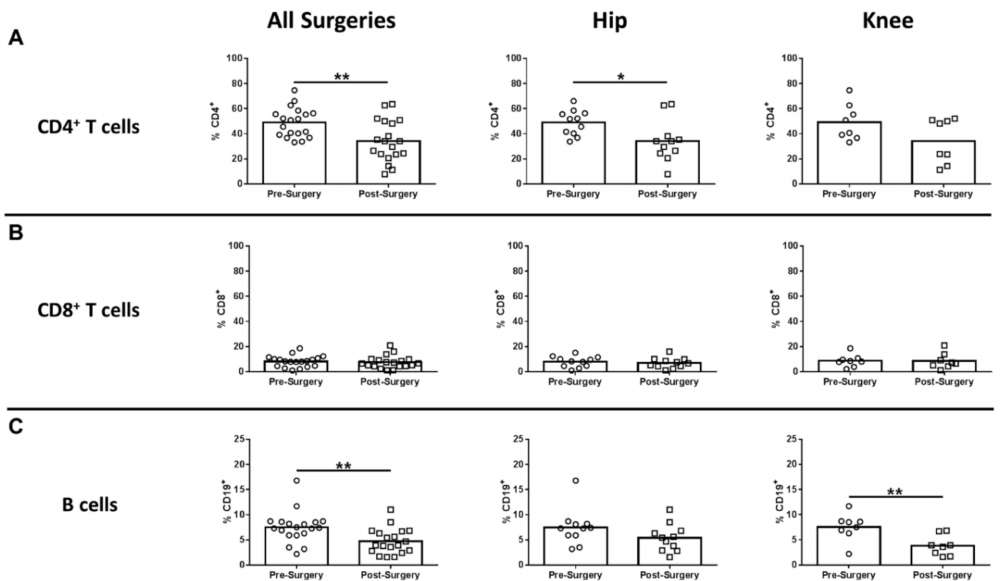
Figure 3. Hip / knee arthroplasty reduces CD4 + T and B cells in the peripheral circulation. Blood samples collected from patients pre- and post-surgery for THA ( n = 11) and TKA ( n = 8) were analyzed by flow cytometry. Results were calculated after gating on live CD45 + cells and quantitation of ( A ) CD4 + T cells, ( B ) CD8 + T cells, and ( C ) CD19 + B cells is presented (* p < 0.05; ** p < 0.01; unpaired two-tailed Student’s t -test).